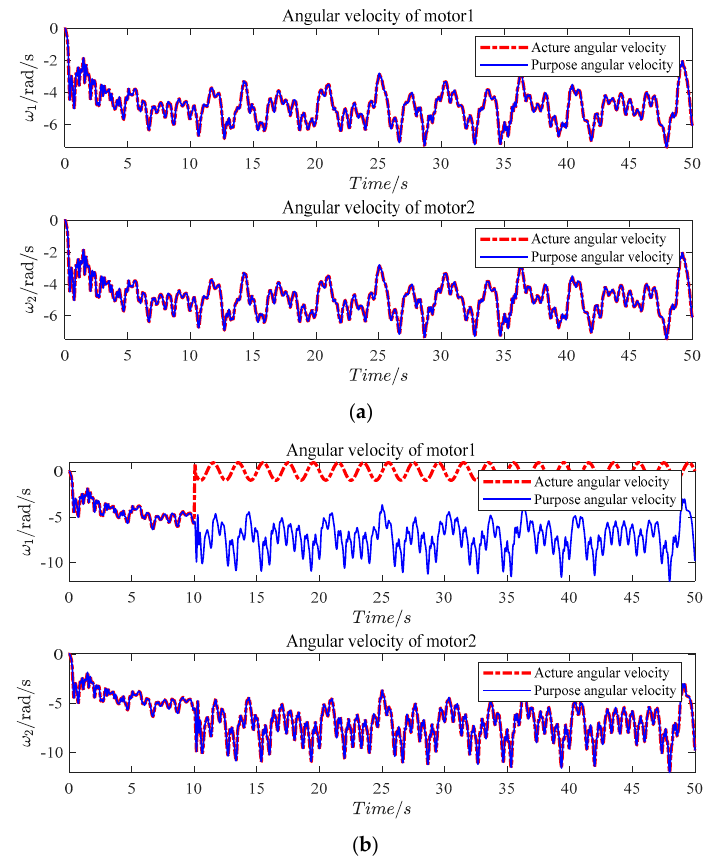
Figure 7. The angular velocity of motors. ( a ) With actuator fault; ( b ) without actuator fault.